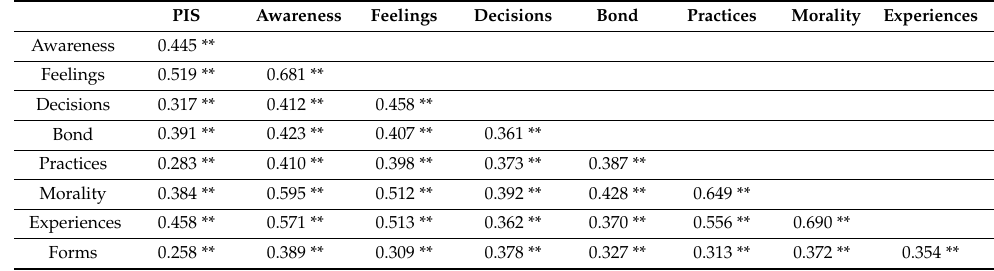
Table 3. Correlation between PIS and SLRT—study